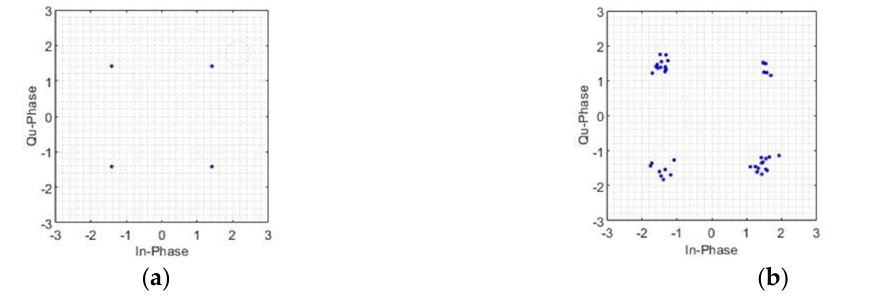
Figure 8. Constellation diagrams. ( a ) Transmitted QPSK signal. ( b ) Received QPSK signal. Figure 9 corresponds to the demodulated QPSK signal. Note the similitude of this graph with the results shown in Figure 5a.